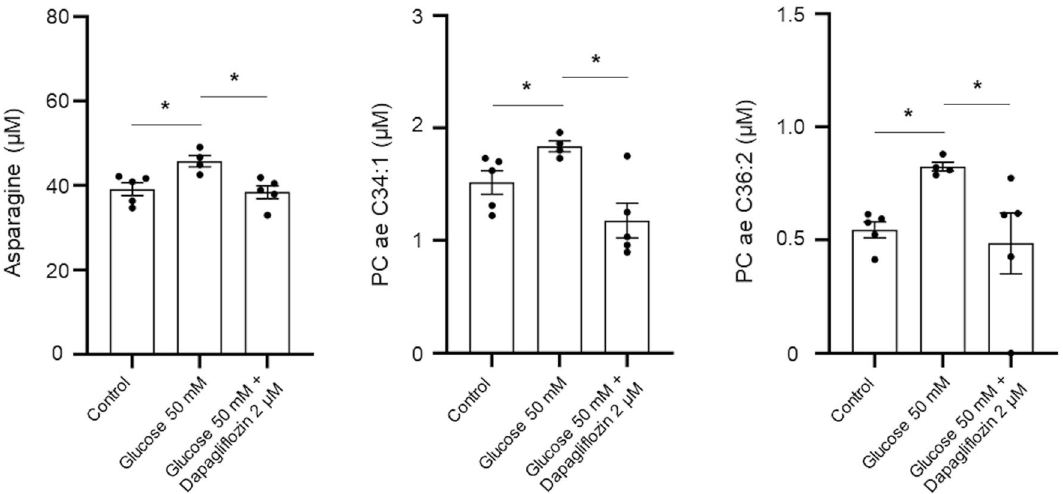
Figure 3. Box plots of differentially expressed metabolite levels in tubular epithelial cells treated with 2 µM dapagliflozin following 50 mM glucose compared to the levels of metabolite identified in those without treatment or treated with 50 mM glucose. * p < 0.05 indicates the significant difference between the groups by unpaired nonparametric Mann–Whitney